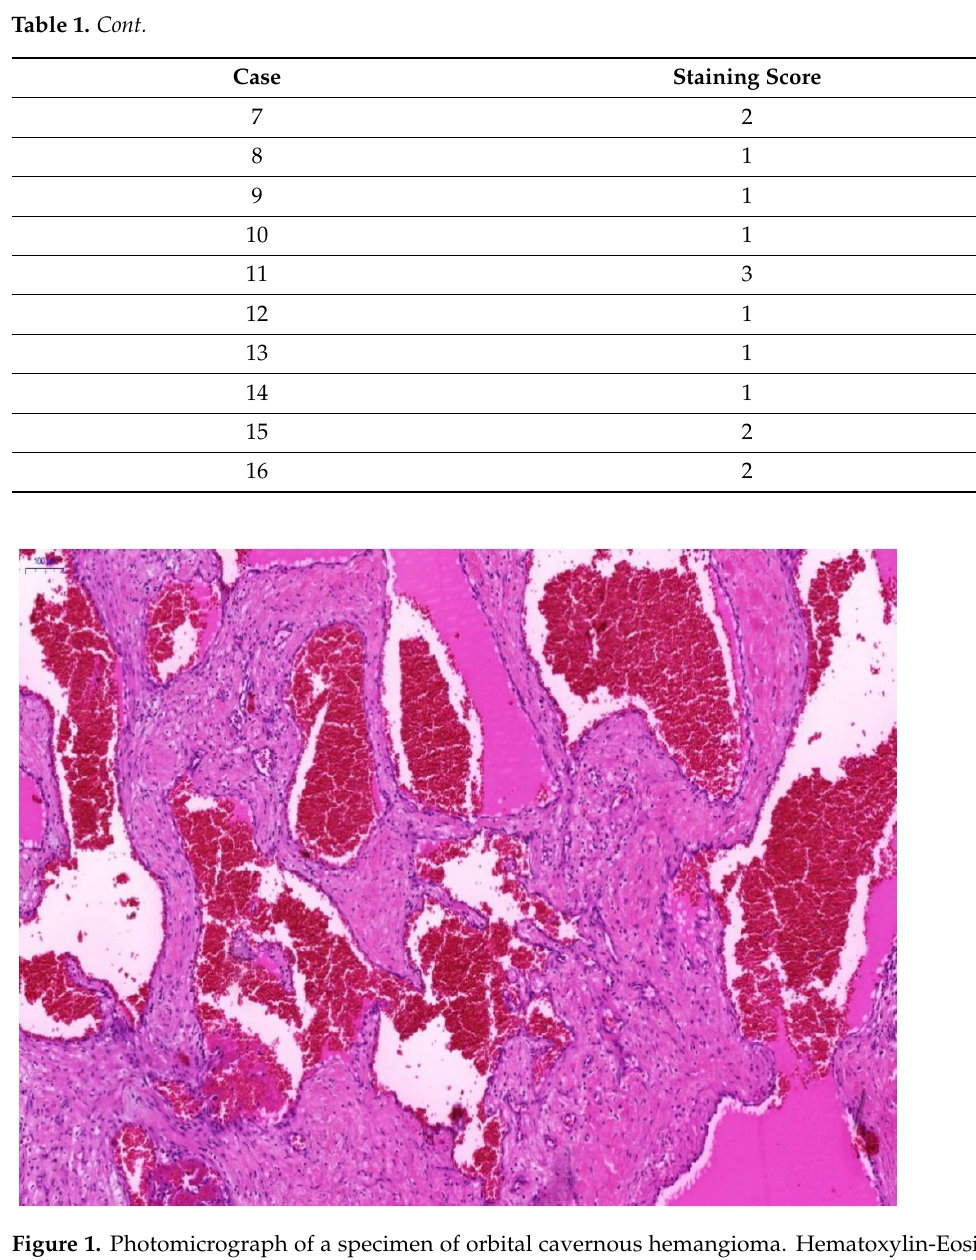
Table 1. Summary of c-KIT staining.